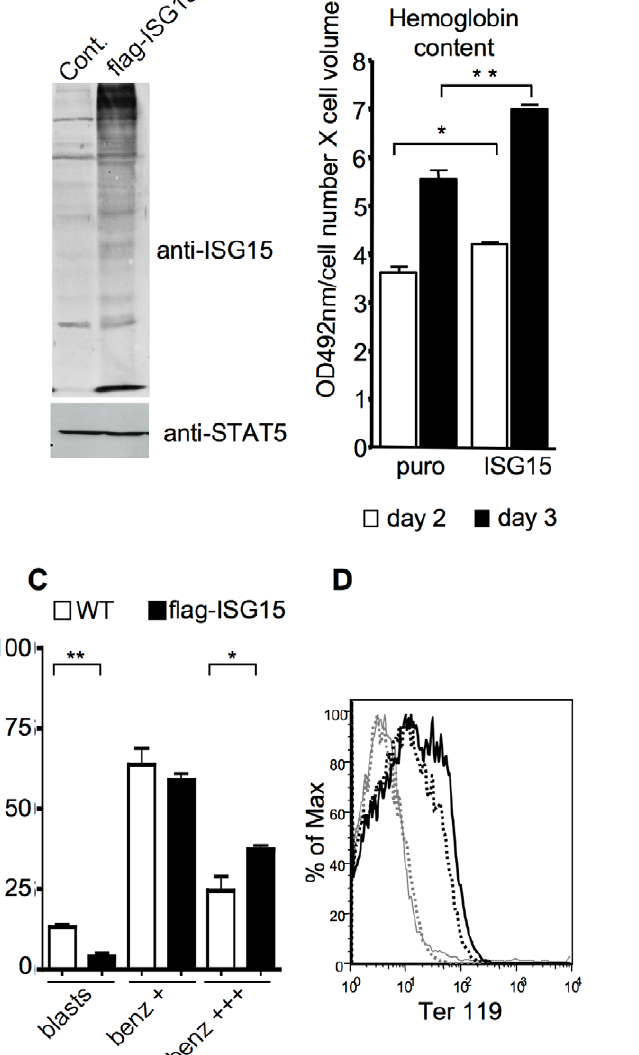
Table 1. Altered distribution of erythroid progenitors in ISG15 -/- bone marrow and splenic